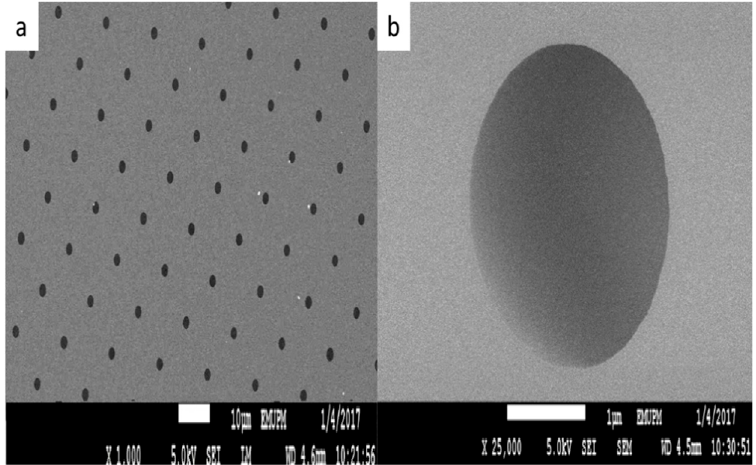
Figure 2. SEM image of the center to center separation of micro-pore array silicon nitride membrane ( a ), and SEM of a single micropore ( b